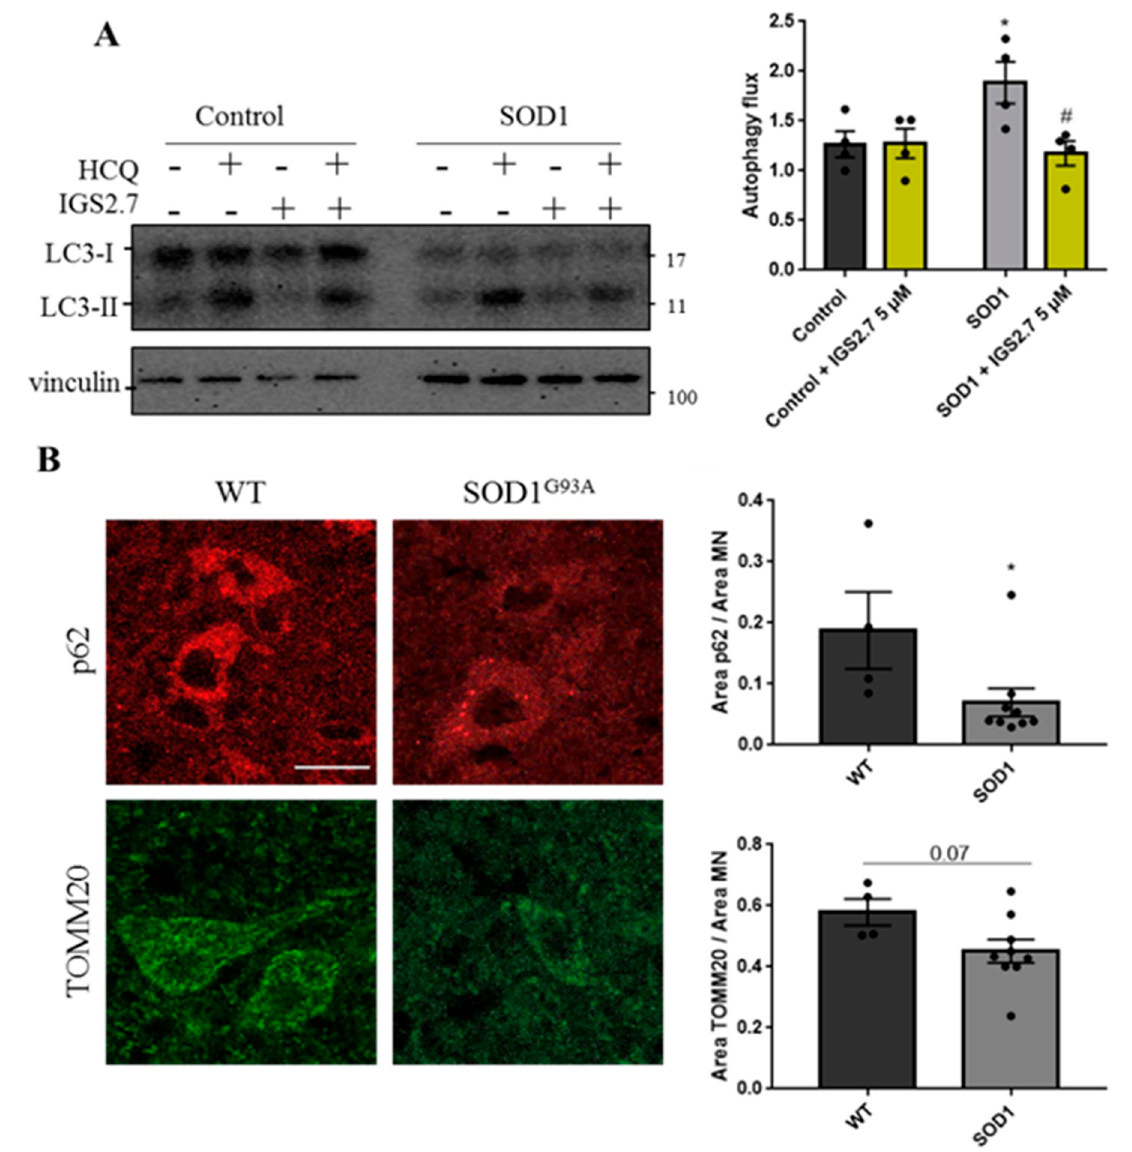
Figure 6. IGS2.7 reduced the autophagy flux in cellular and animal SOD1 models of ALS. ( A ) Lym- phoblasts were incubated in the presence and absence of 5 µ M IGS2.7 for 24 h. Hydroxychloroquine (HCQ) was added during the last 3 h when indicated. Each point represents the mean of four inde- pendent experiments. Data represent the mean ± SEM of four controls and SOD1 lymphoblastic cell lines (significance was determined by one-way ANOVA followed by Dunnett’s multiple comparisons test, where * p < 0.05 vs. control and # p < 0.05 vs. SOD1-ALS). ( B ) Histological samples of the anterior horn of the spinal cord of SOD1 G93A and wild-type mice. Tissues were immunostained for p62 and TOMM20 and quantified per MN. Data represent mean ± SEM of four different control and nine transgenic mice (significance was determined by unpaired two tailed t -test, where * p < 0.05 indicates a significant difference from control). Scale bar = 20 µ